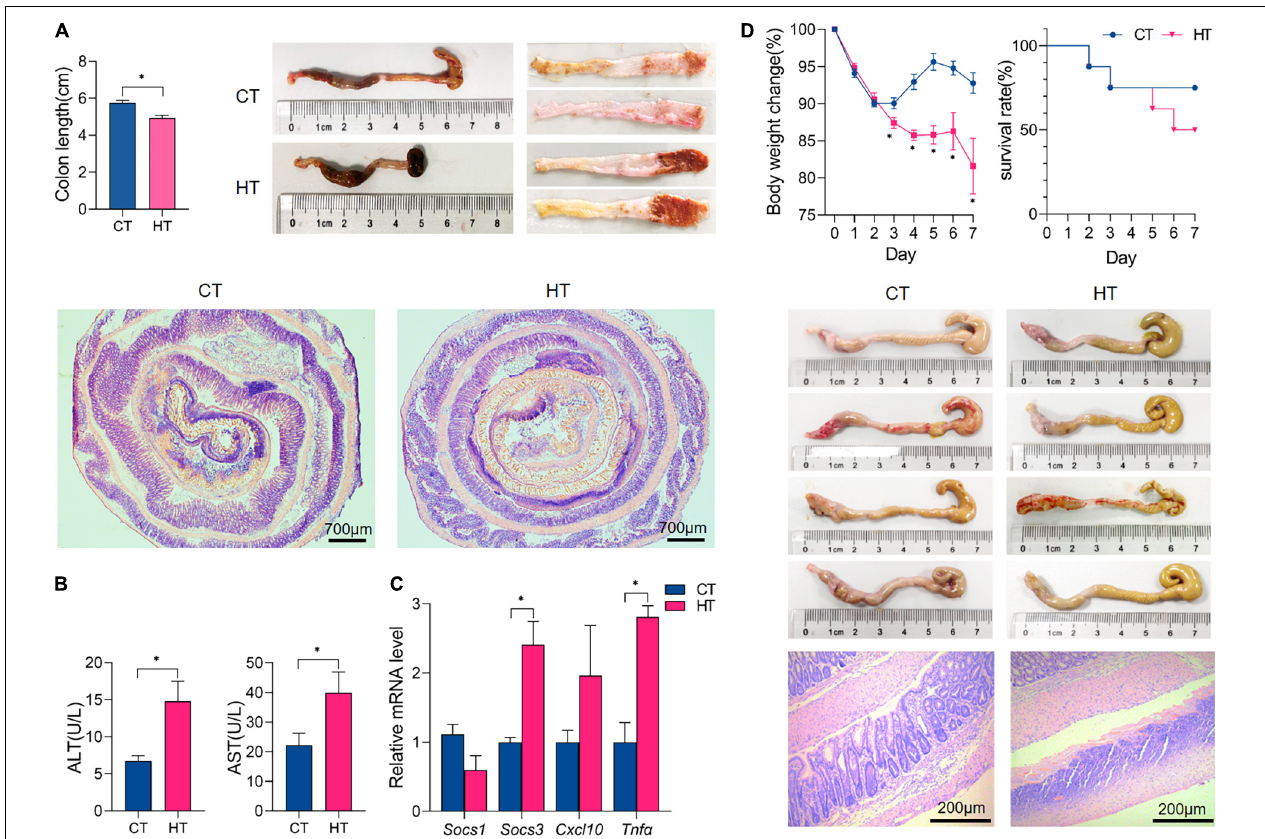
FIGURE 6 | High-fat exacerbated the disease severity of TNBS-induced colitis. (A) All mice were sacrificed on day 3, and the colons were collected to estimate mucosal damage by detecting colon lengths; gross morphology of the colons on day 3 after TNBS treatment; the representative histological sections were observed under microscopy (magnification: 2.5 × ). (B) The alanine aminotransferase (ALT) and aspartate aminotransferase (AST) activity in the serum of each group of mice. (C) qPCR quantitation of pro-inflammatory cytokines and chemokines in colonic mucosa on day 3 after TNBS treatment. (D) Body weight changes for each group of mice within 7 days after TNBS installation and survival curve within 7 days; gross morphology of the colons on day 7 after TNBS treatment; and colon histology by hematoxylin and eosin staining on day 7 (magnification: 100 × ). n ≥ 3. The data were shown as mean ± SEM. ∗ p < 0.05. CT, control diet and TNBS group; HT, high-fat diet and TNBS